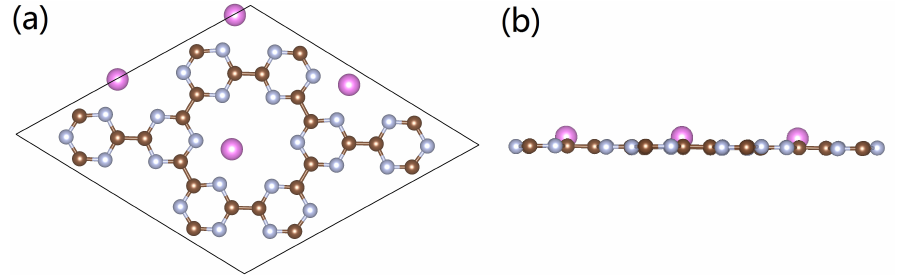
Figure 2. ( a , b ) Optimized configuration of the Al-doped g-CN monolayer. Brown, silver, and pink spheres represent C, N, and Al atoms,